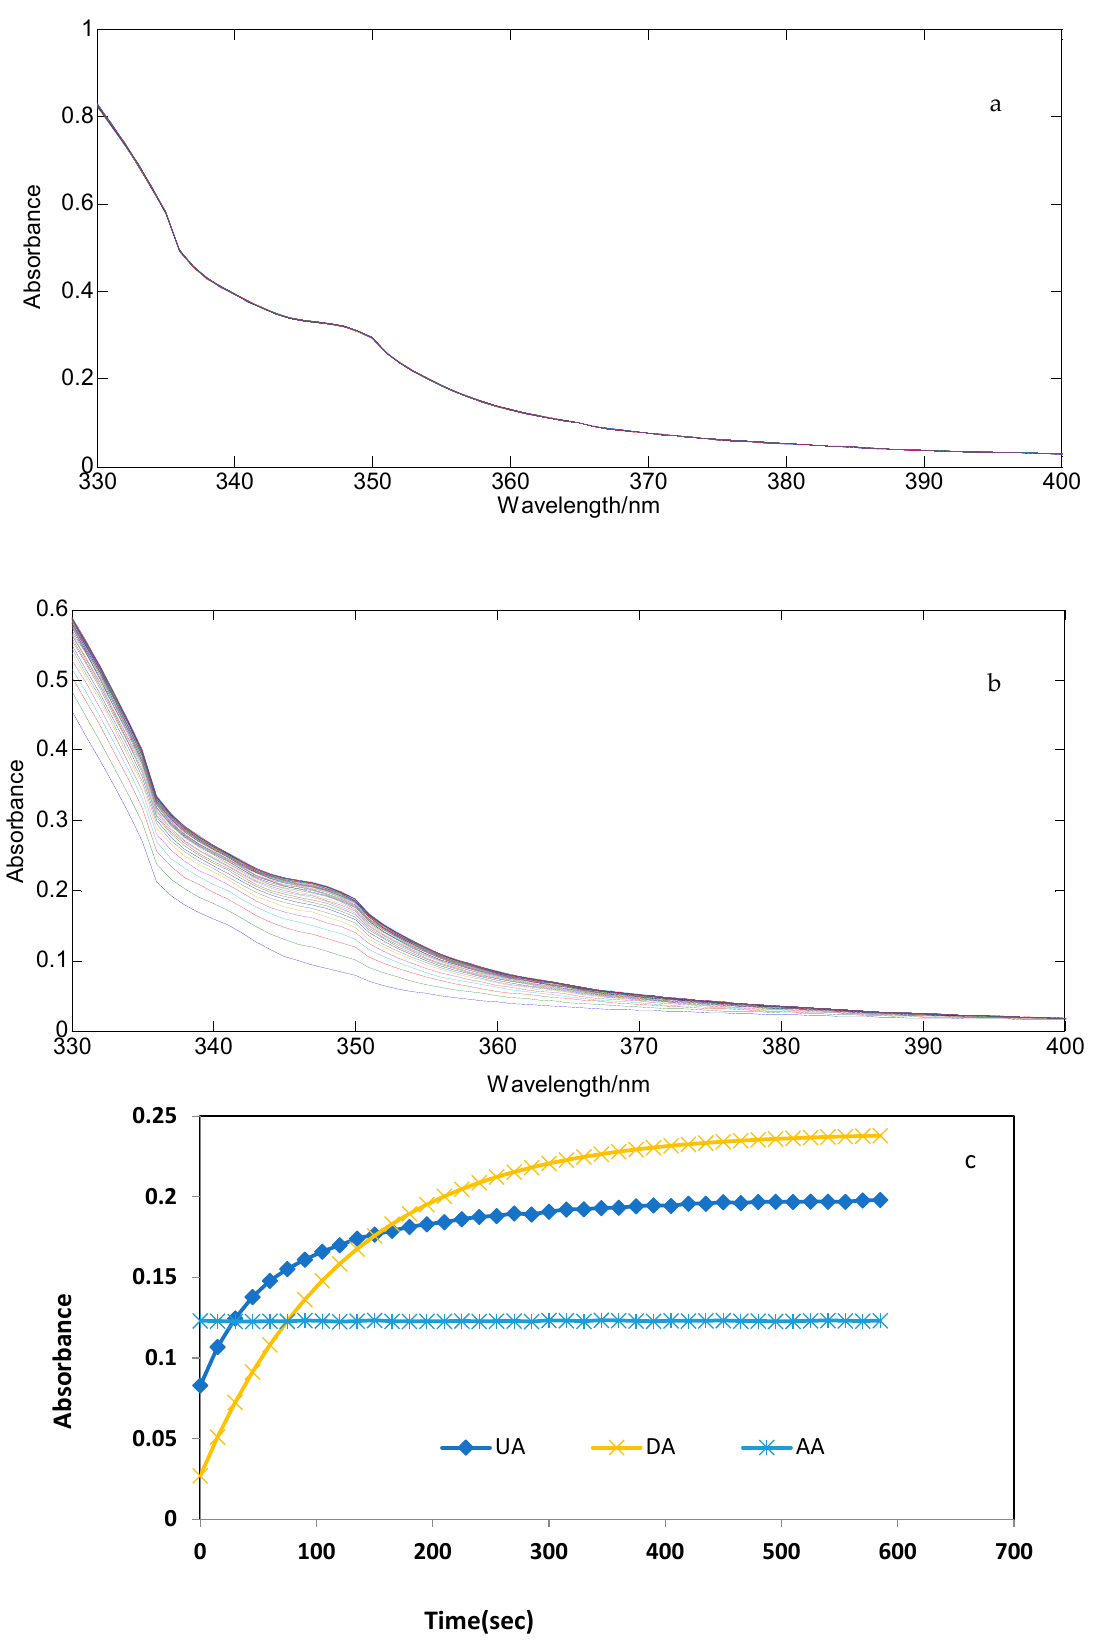
Figure 1. Spectrophotometric spectra of ( a ) UA, ( b ) DA and ( c ) Kinetic profiles of DA, UA and AA at acetate media (pH = 4.5) and wavelength 320 nm.